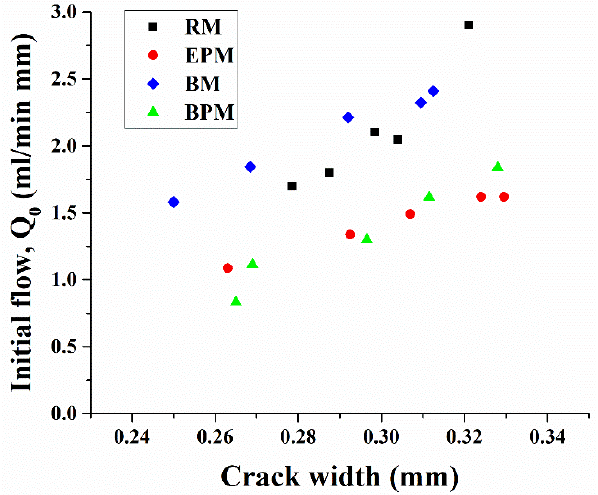
Figure 10. Initial water flow rate versus crack width .